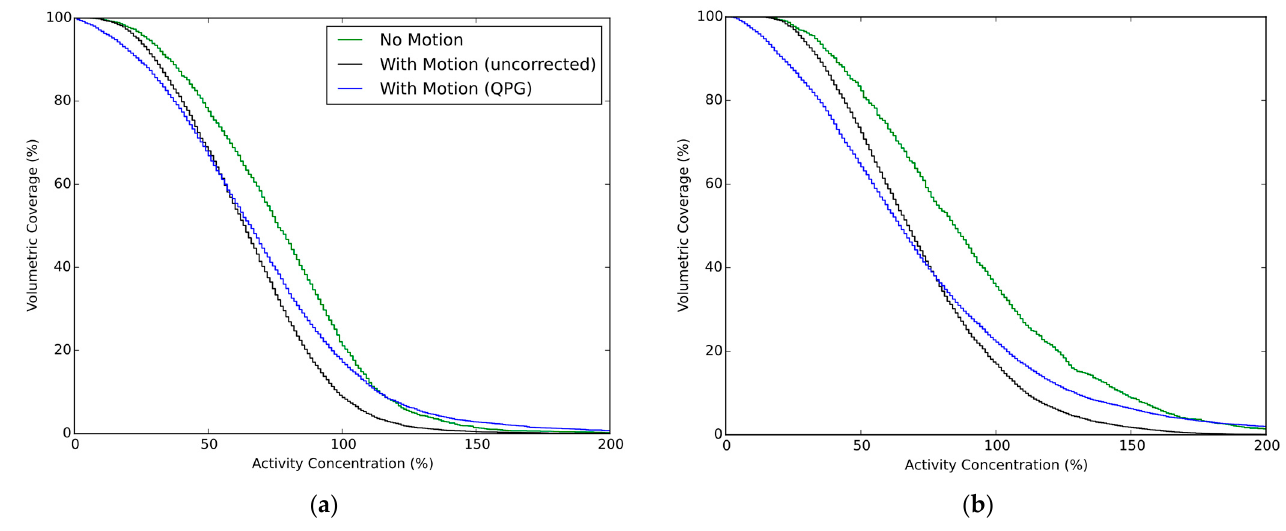
6 of 11 Figure 2. PET images (coronal slices) from the phantom with and without motion applied. The upper row of images is from the Discovery 710. The lower row is from the Biograph mCT. The grey scale maximum equals the true activity concentration in the hot spheres, with minimum at zero. The activity concentration ratio between the spheres and background was 8:1. For each scanner the images show a similar slice of the phantom while stationary, while in motion but without correc-